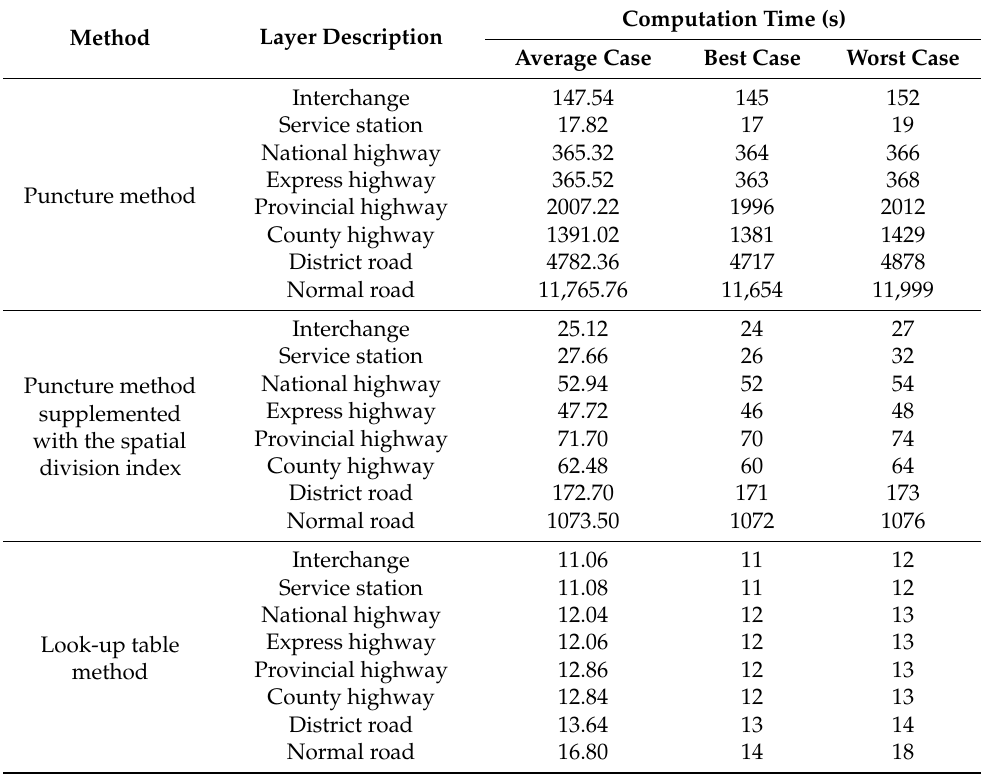
Table 5. The individual segment layer using 100,000 samples with 50